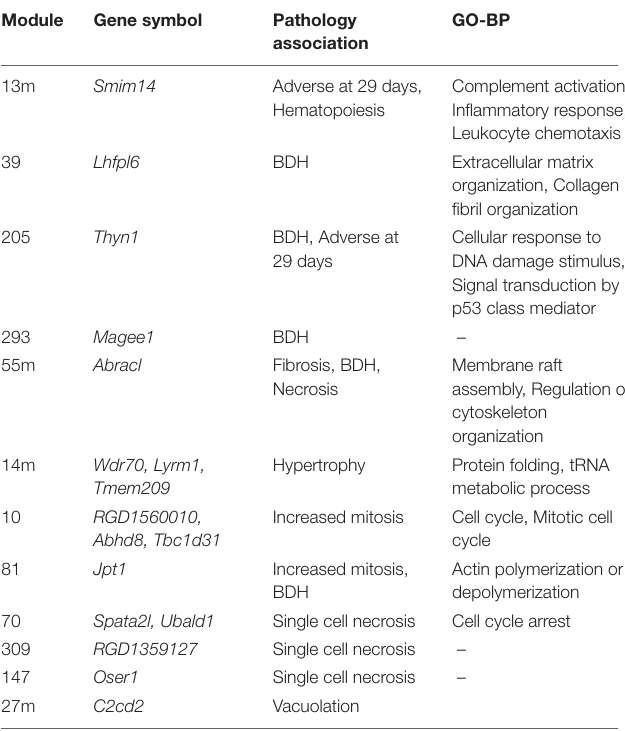
TABLE 7 | Orthologs to human dark genes present in modules associated to pathologies in rats described by Sutherland et al. (2017). Module